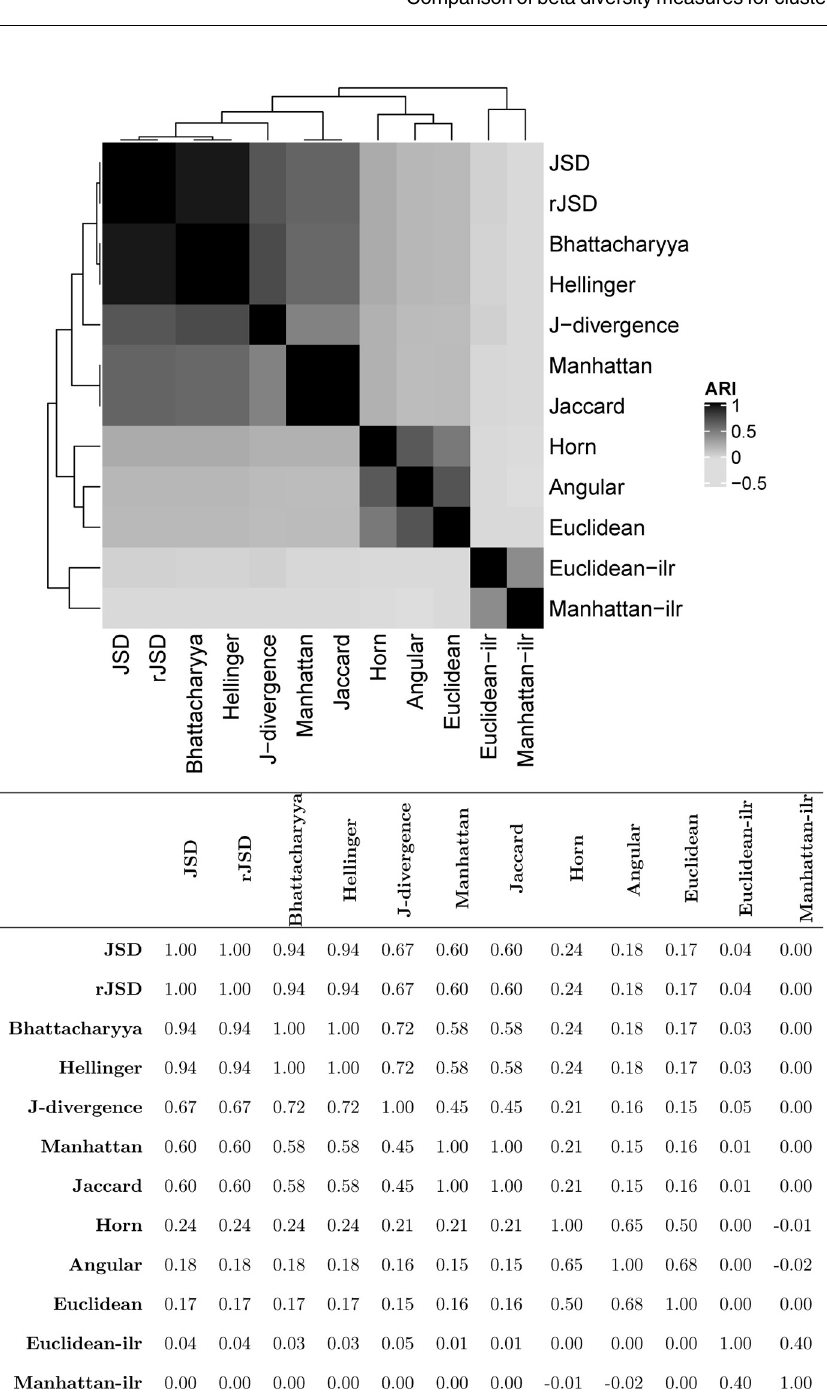
the compositional changes in this dataset may be mainly located at a high abundance level.